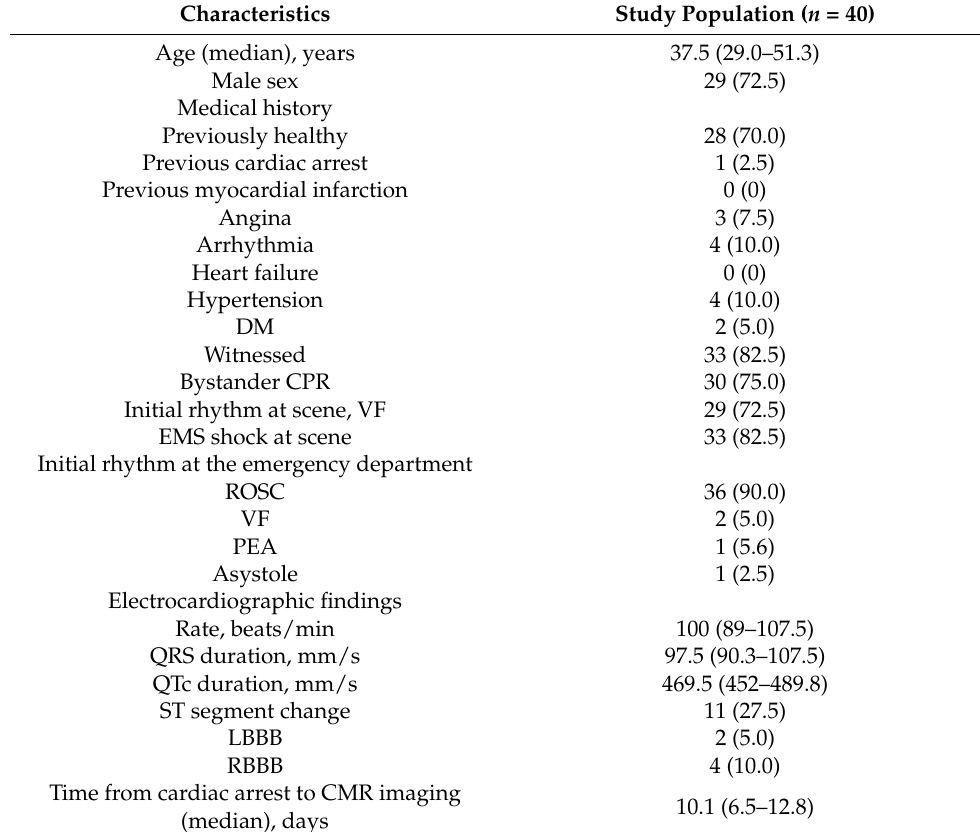
Table 1. Baseline demographic and clinical data of the study